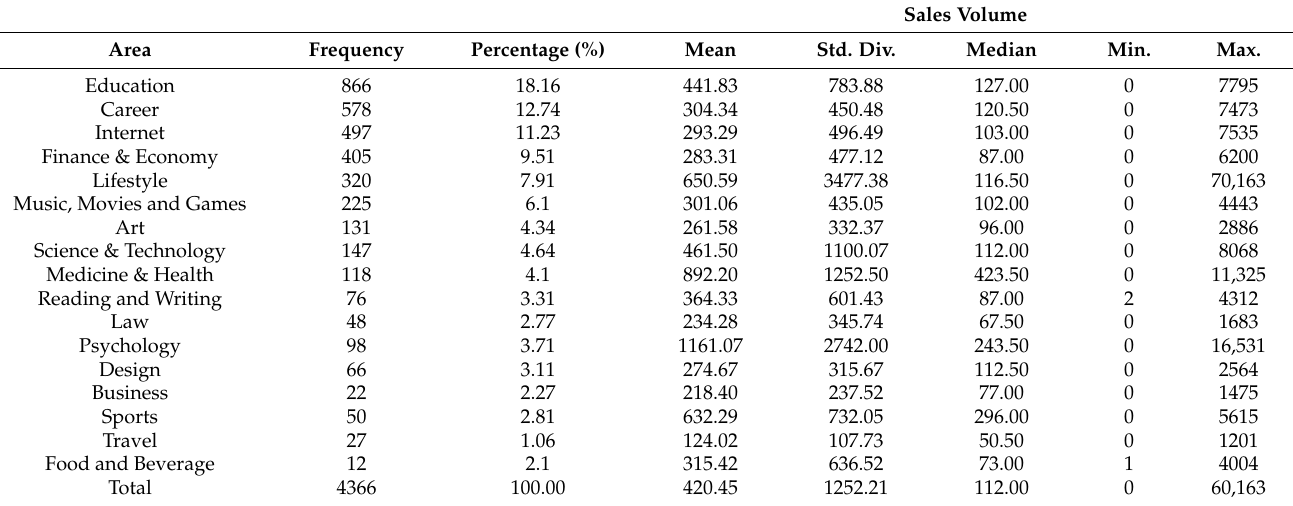
Table 3. Descriptive statistical analysis of knowledge domains